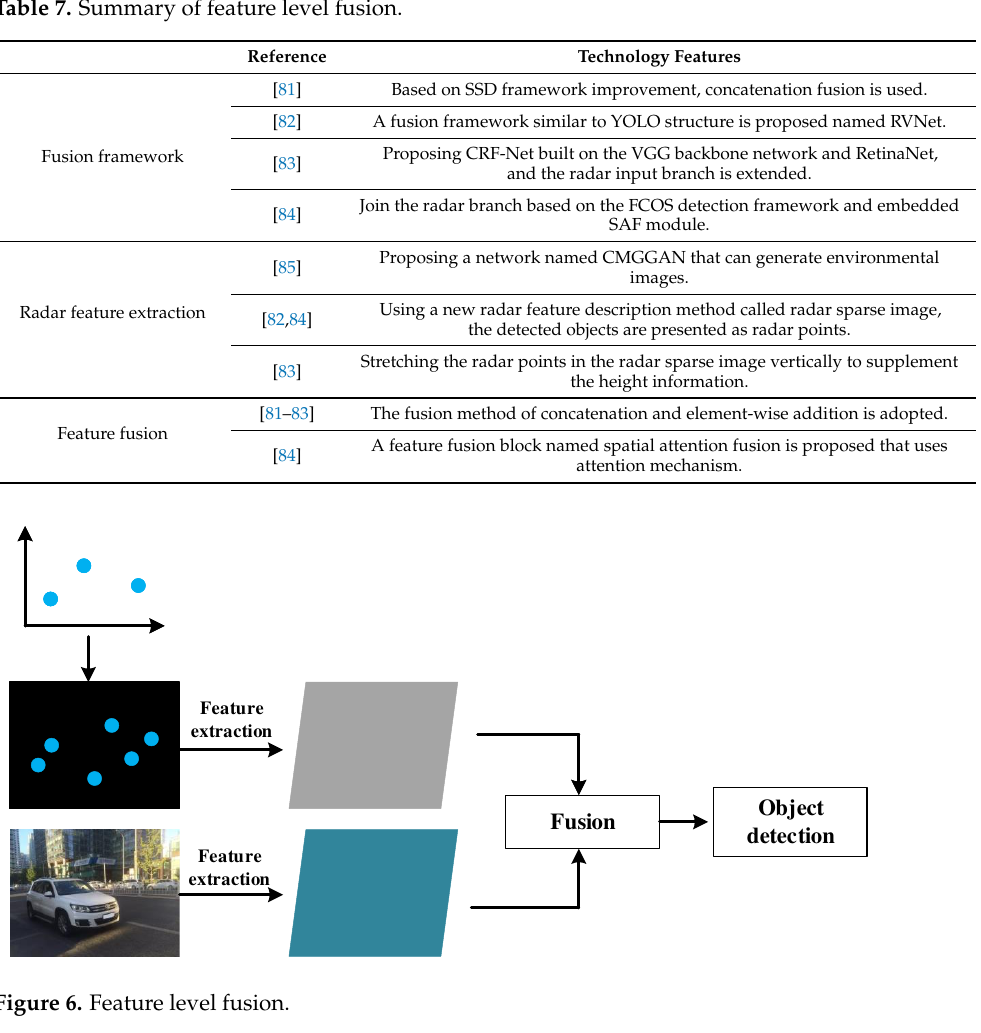
Table 7. Summary of feature level fusion.